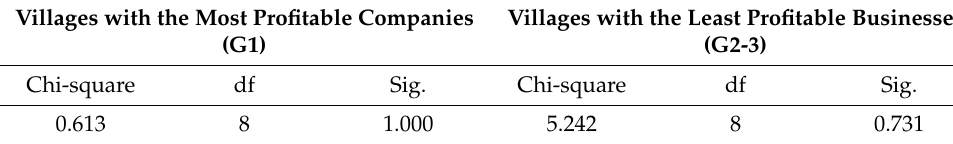
Table 7. Model goodness-fit test. Hosmer and Lemeshow test. Villages with the Most Profitable